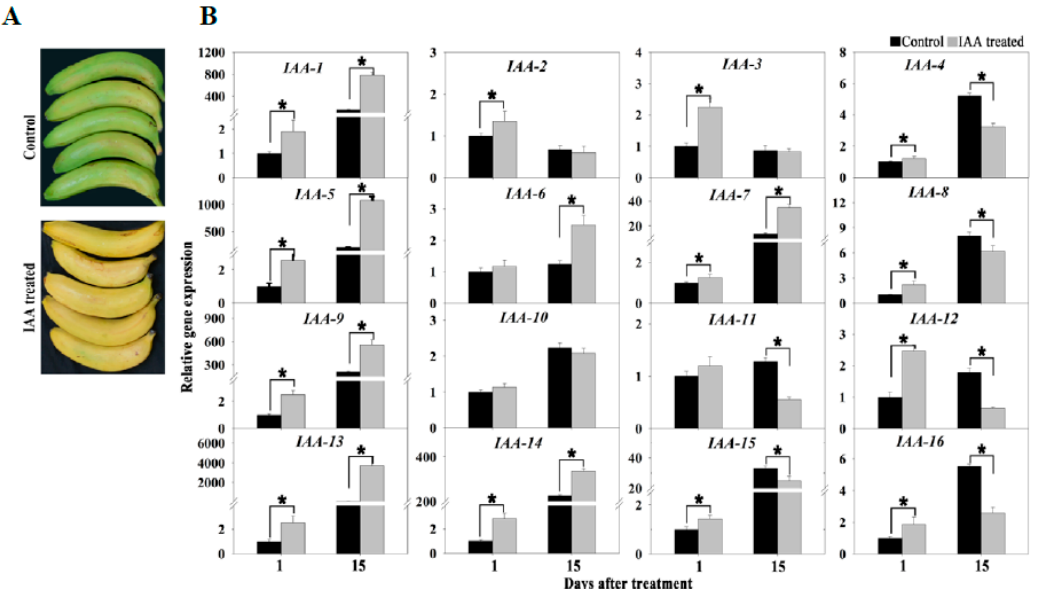
Figure 8. Effect of exogenous IAA treatment on fruit ripening and gene expression. ( A ) Visual appearance of banana fruit treated with 0.1 mM IAA after 15 d of storage. ( B ) Expression of selected ripening-related genes in the peel of banana fruit with 0.1 mM IAA after 1 and 15 days of storage. IAA-1, auxin-responsive family protein; IAA-2, OsSAUR57-auxin-responsive SAUR gene family member; IAA-3, auxin-induced protein 22D; IAA-4, OsSAUR37 - auxin-responsive SAUR gene family member; IAA-5, auxin-responsive family protein; IAA-6, SAUR family protein; IAA-7, 1-aminocyclopropane-1-carboxylate oxidase;